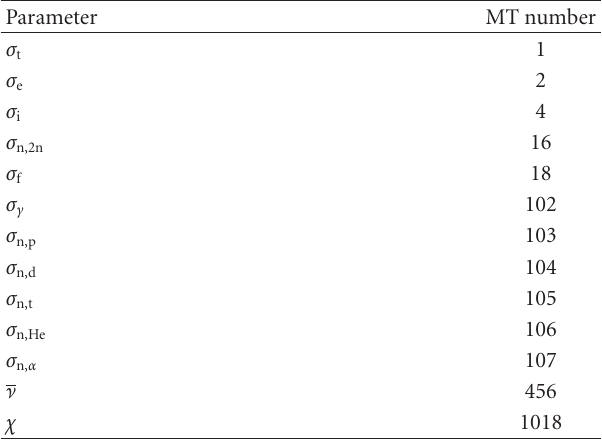
Table 1: Parameters for which there exists covariance data in the SCALE